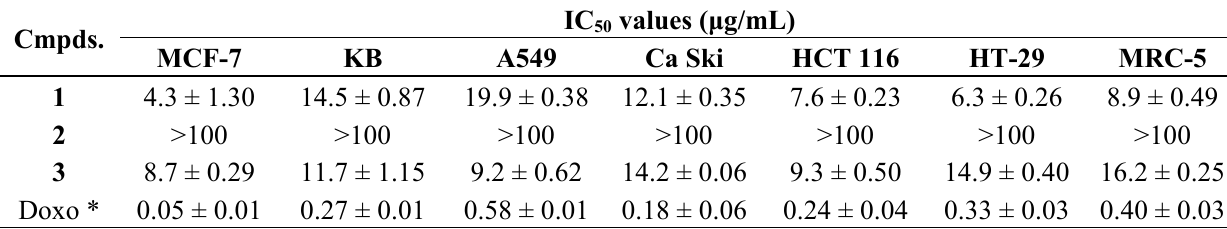
Table 2. Cytotoxic activity (IC and non-cancer cell